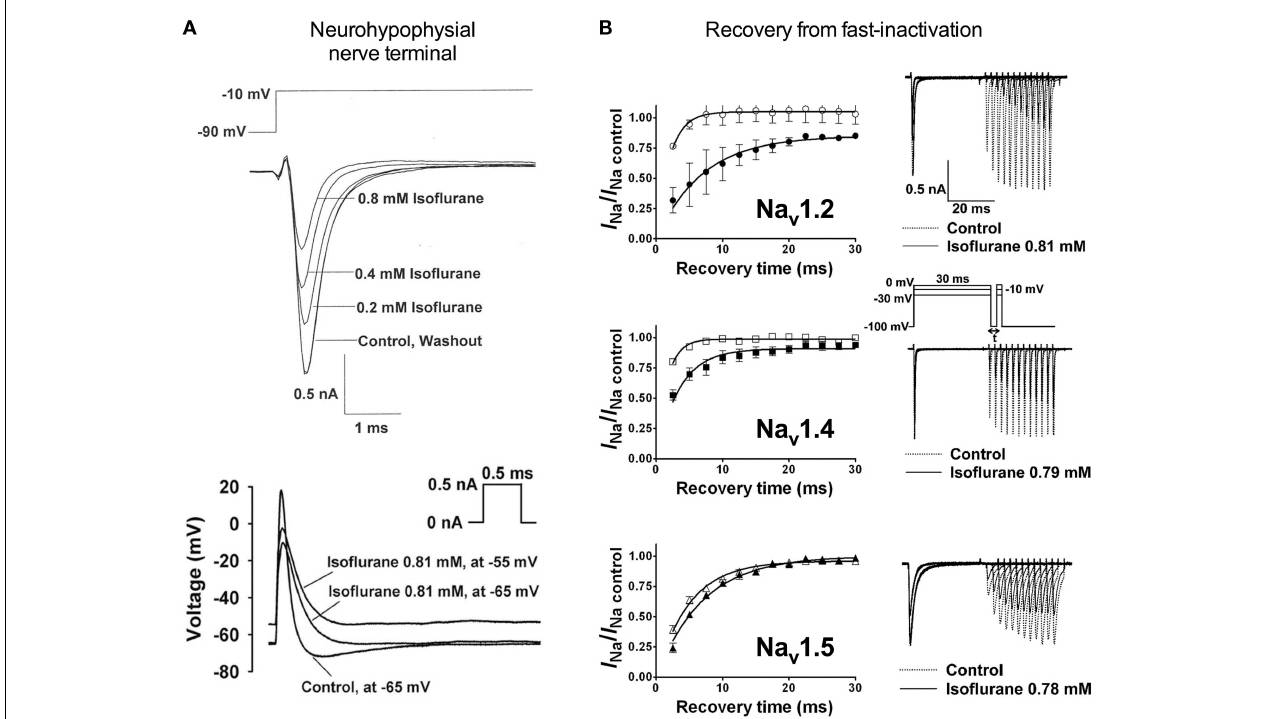
FIGURE 2 |Volatile anesthetics inhibit Na + channels in various expression systems. [ (A) , upper panel] Electrophysiological recordings of isolated rat neurohypophysial nerve terminals show a reversible block of Na + currents and [ (A) , lower panel] action potentials evoked by small current injections at clinically relevant concentrations of isoflurane (Ouyang et al., 2003; Ouyang and Hemmings, 2005). (B) Effects of isoflurane on channel recovery from fast-inactivation of three different Na + channel isoforms